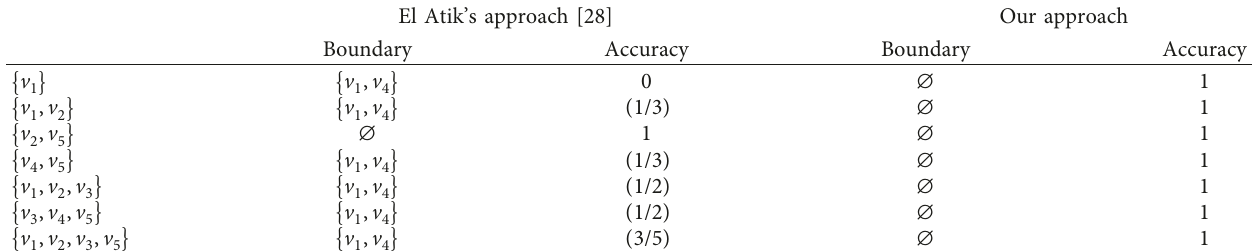
Table 6: Comparisons between El Atik’s approach [28] approach and our